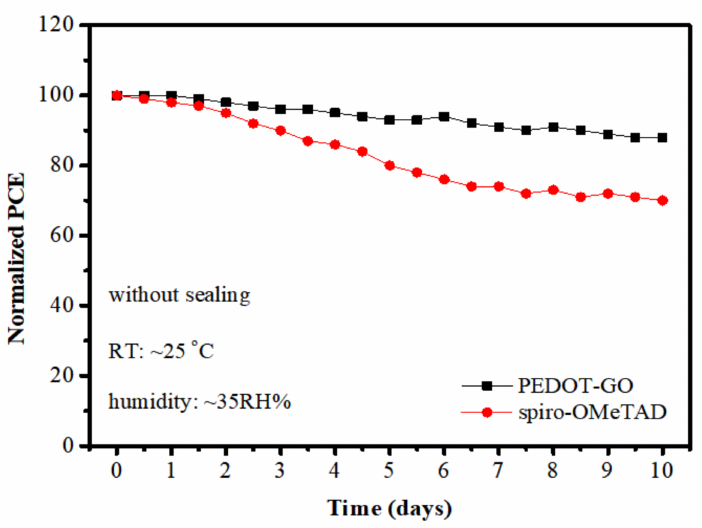
Figure 4. The durability test of spiro-OMeTAD-based solar cells and PEDOT-GO-based solar